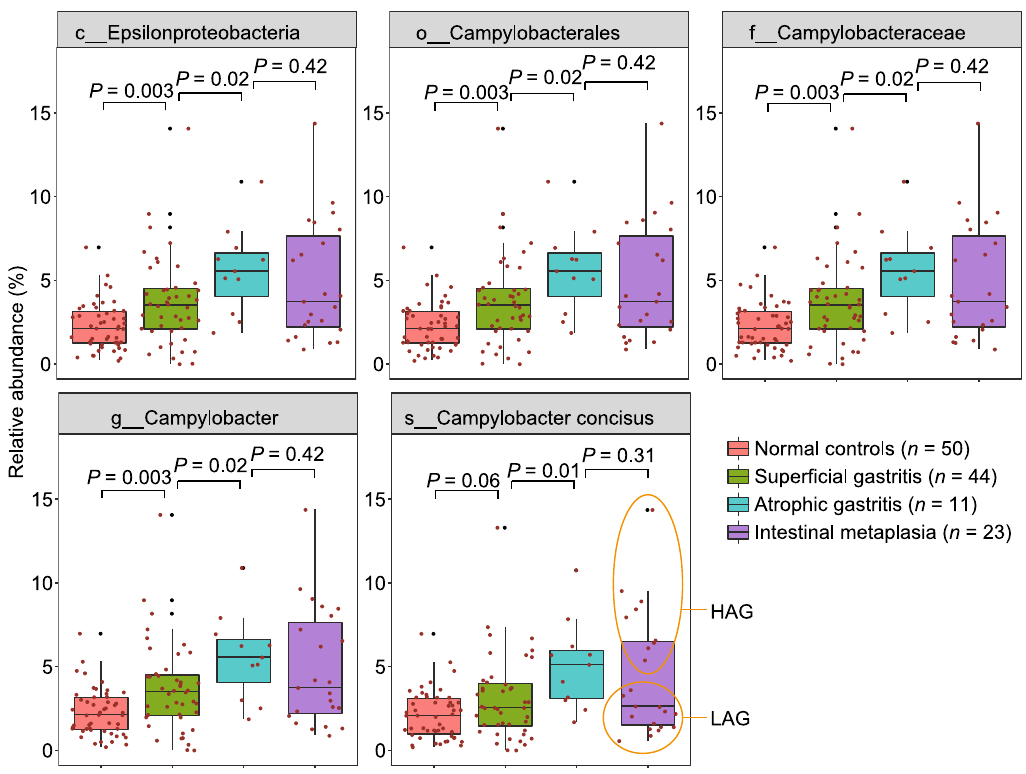
Figure 5. The abundance of Campylobacter concisus during the precancerous cascade. Boxes describe the interquartile range (IQR). The y-axis represents the relative abundance of the corresponding species in all samples. Statistical comparison by Wilcoxon rank-sum